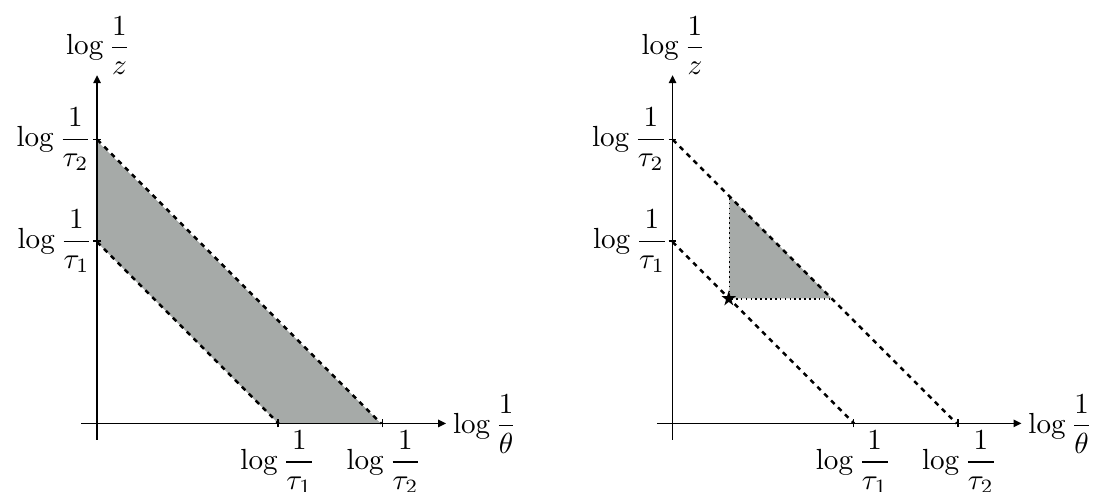
Figure 2. Illustrations of the forbidden regions (grayed) for gluon emission that sets the value of (cid:28) 2 , given a value of (cid:28) 1 . The location of the emission that sets the value of (cid:28) 1 in the Lund plane is illustrated by the star. On the left is the forbidden region if the gluon is emitted o(cid:11) of the initiating quark; the only requirement is that the gluon must enforce (cid:28) 2 < (cid:28) 1 . On the right is the forbidden region if the gluon is emitted o(cid:11) of the gluon that sets the value of (cid:28) 1 : it must be both at smaller angle and have smaller energy than the (cid:12)rst emitted